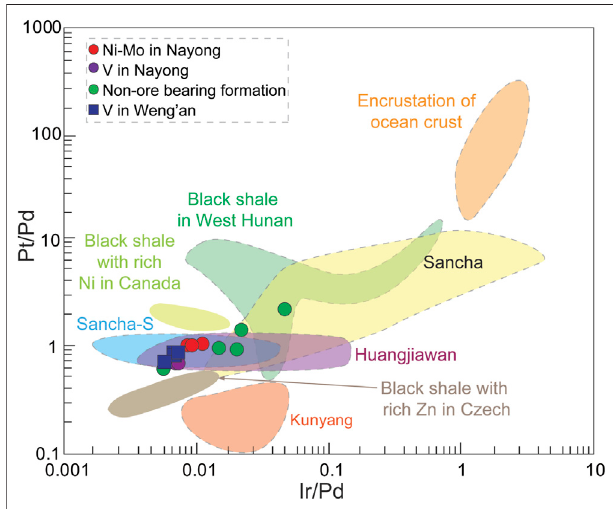
FIGURE7| (Pt/Pd) – (Ir/Pd)diagramfordifferentsediments(datasources as for Figure 6 ).